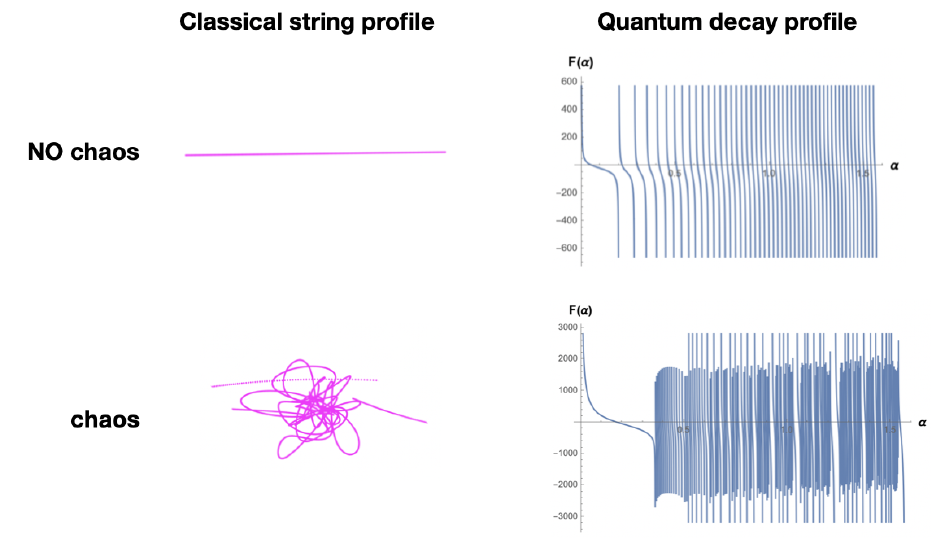
Figure 6 . Comparison between classical string profiles and decay amplitudes.